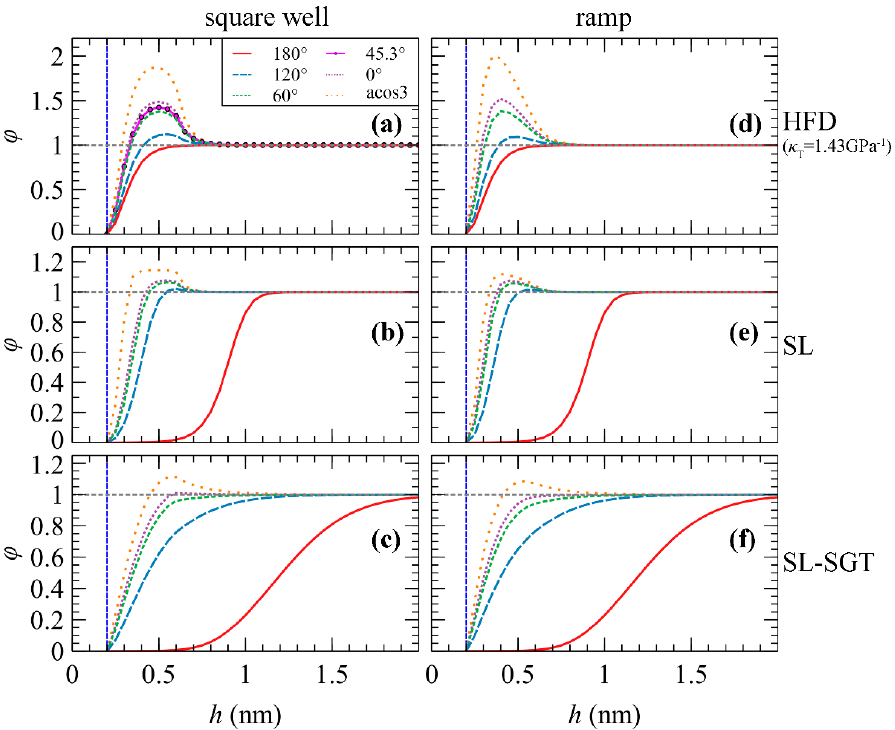
Figure 3. Density profiles of PE–vacuum interfaces for θ = 180° (red), 120° (blue), 60° (green), 45° (magenta), 0° (violet), and acos(3)° (orange) using the ( a , d ) HFD, ( b , e ) SL, and ( c , f ) SL-SGT EoS in conjunction with (left) square well or (right) ramp potentials.